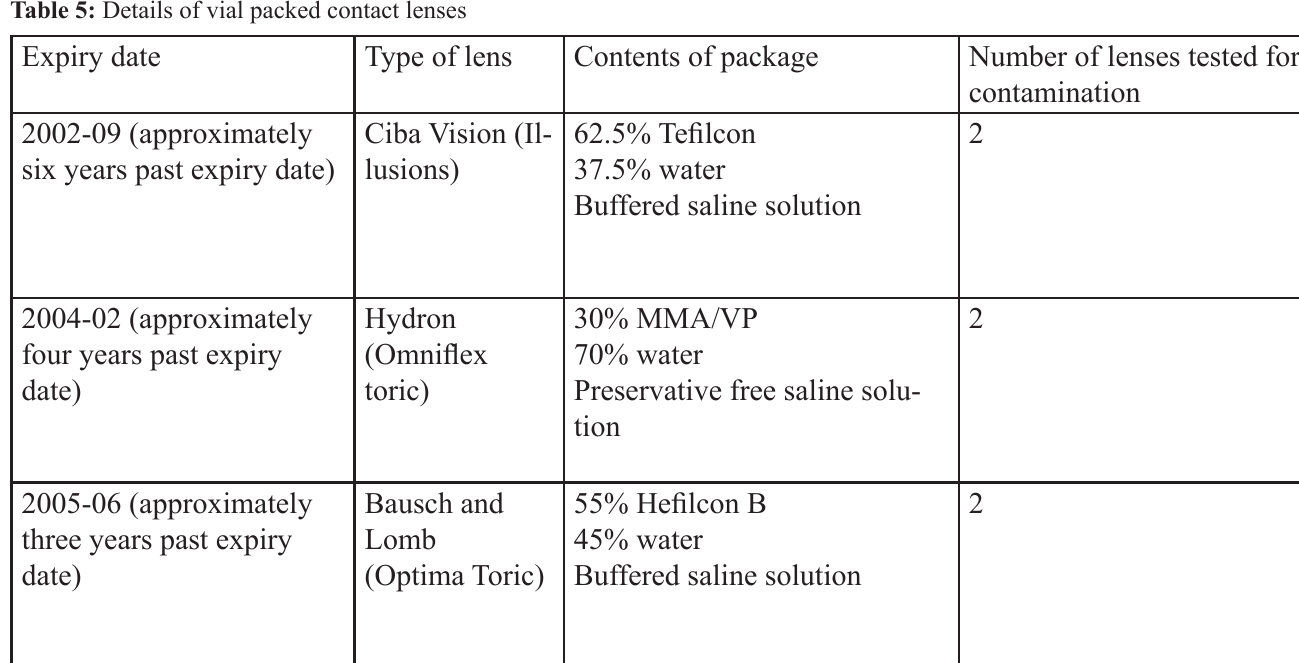
Table 5: Details of vial packed contact